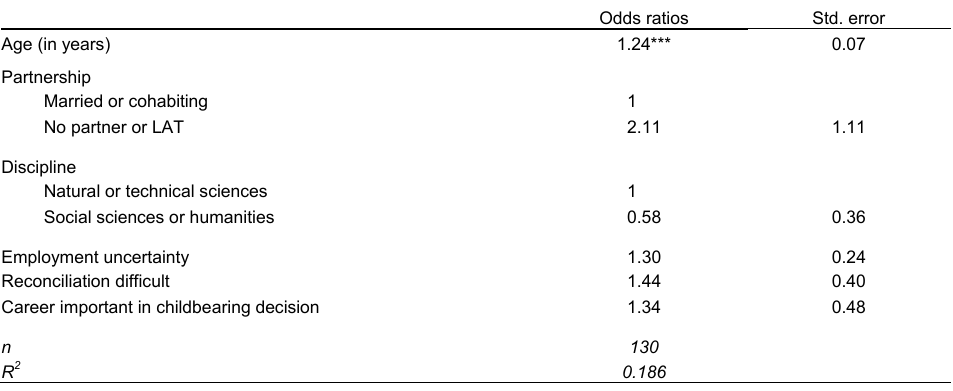
Table 3 : Determinants of intention to stay childless among childless female researchers, logit model Age (in years) 1.24*** 0.07